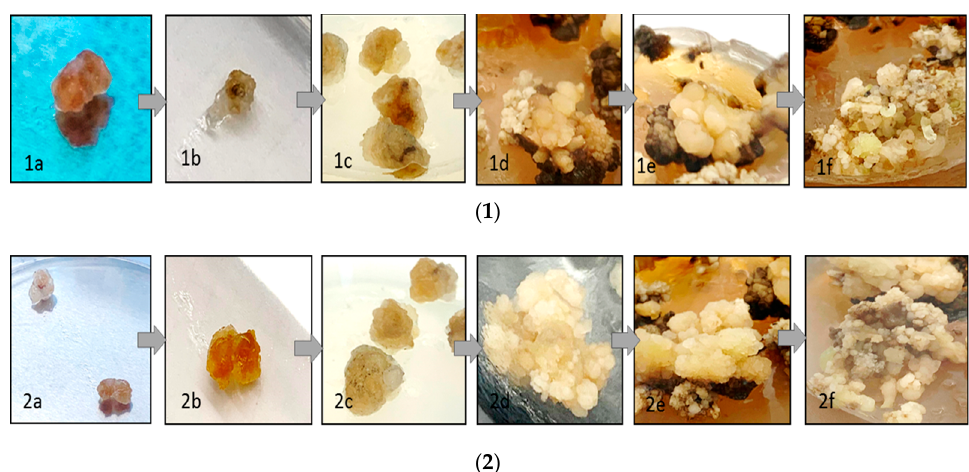
Figure 1. Callus tissues and callus induction in the MS medium containing (kinetin (0.5 mg/L), 2,4-